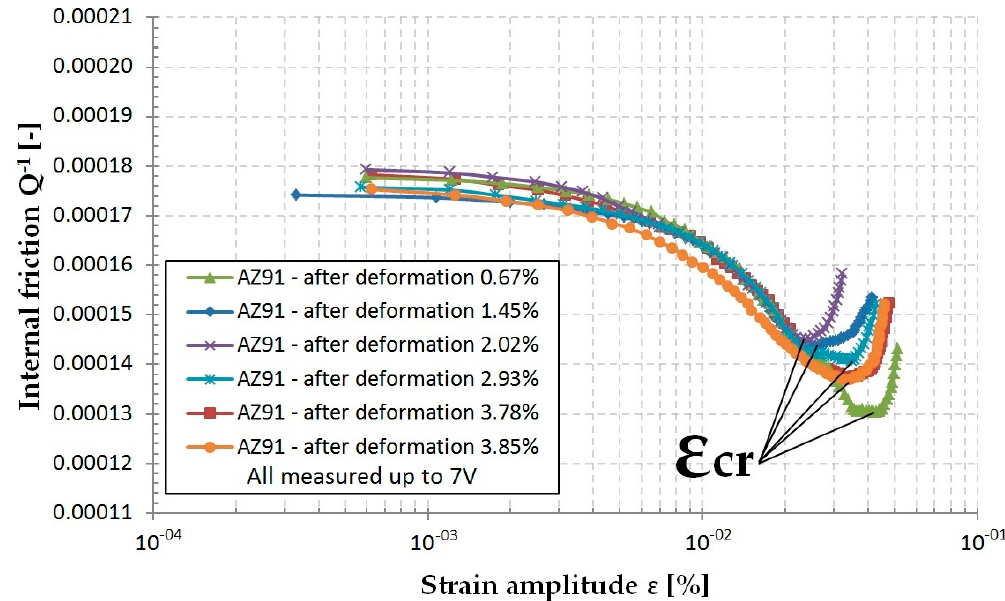
Figure 16. Amplitude dependent internal friction measured in the AZ91 alloy after plastic deformation.